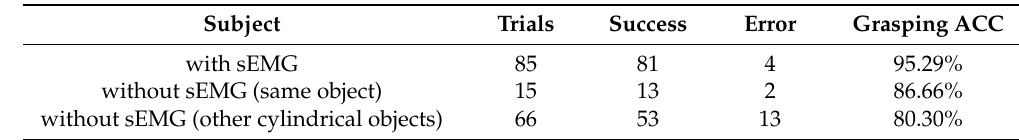
Table 4. Comparison of the grasping accuracy for the proposed (visual data + sEMG) compared to the previous method (only visual